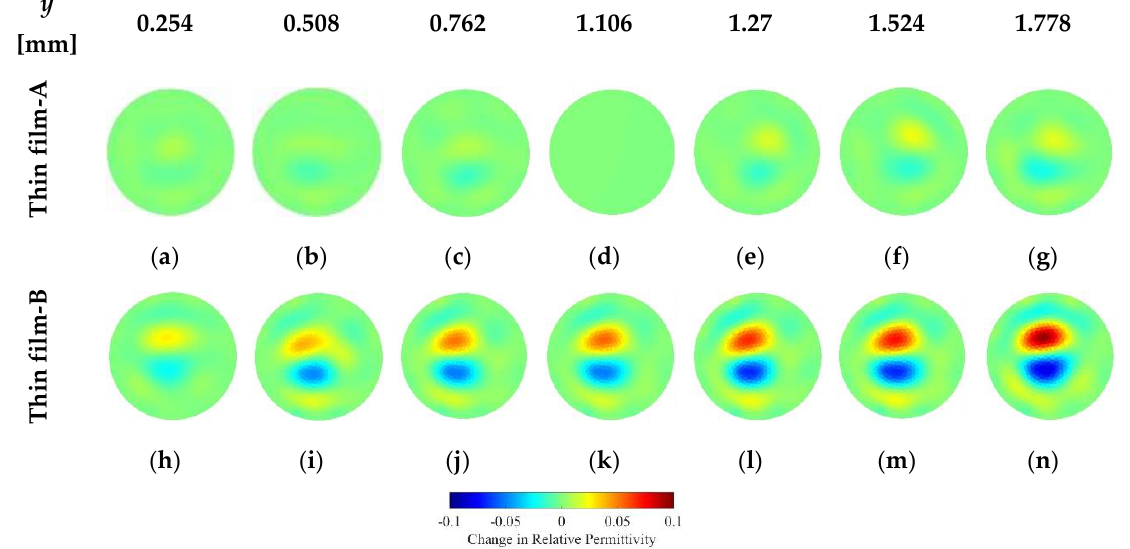
Figure 13. Thin films-A and -B coated onto osseointegrated prostheses phantoms were subjected to transverse loading. The corresponding changes in electrical permittivity with respect to the undeformed states are shown. ( a – g ) describes the permittivity changes for the specimen coated with Thin film-A, while ( h – n ) illustrate the electrical permittivity changes of the Thin film-B-coated specimen.